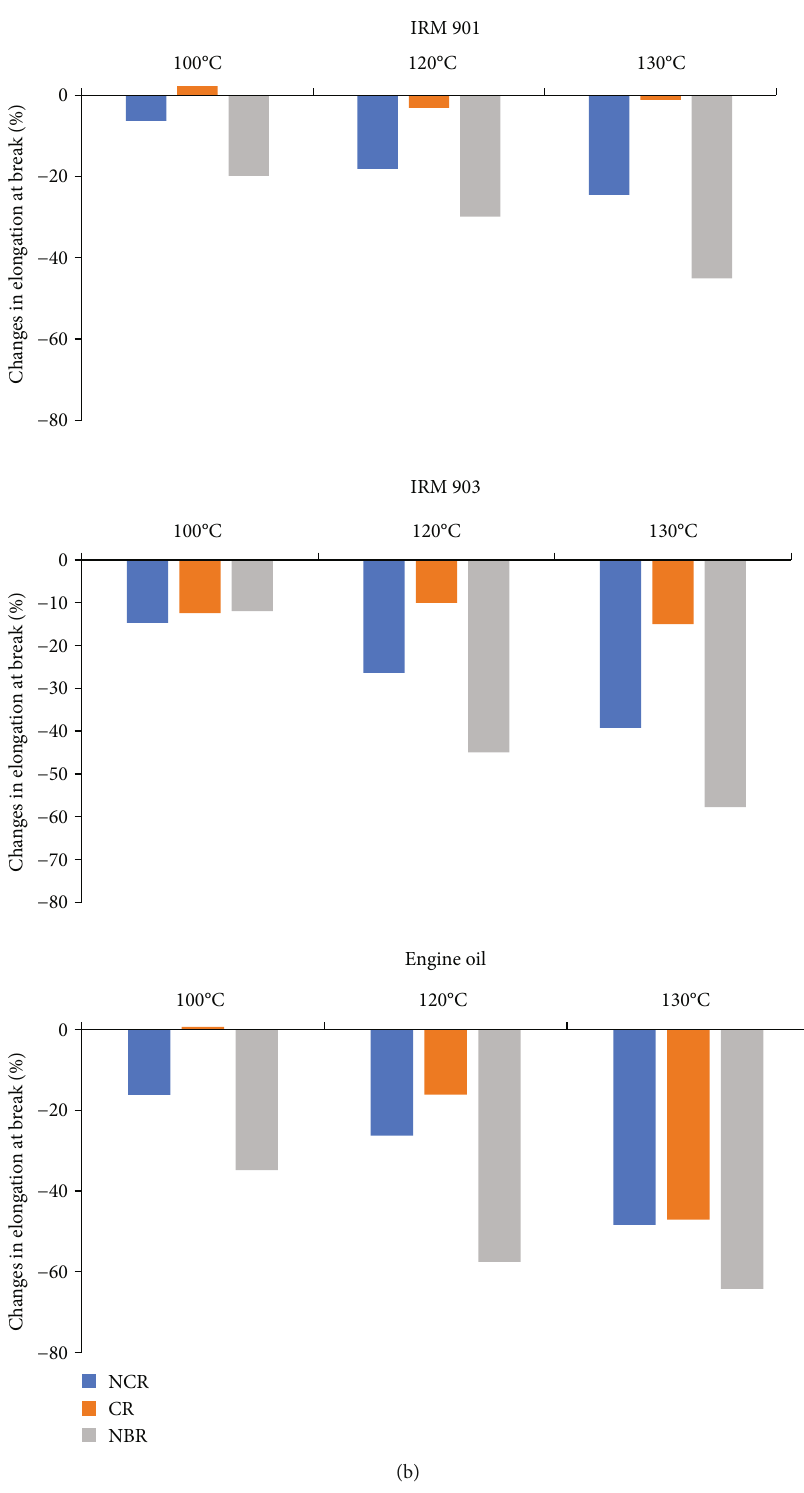
Figure 7: Changes in (a) tensile strength and (b) elongation at break of vulcanizates of acrylonitrile-chloroprene rubber (NCR), chloroprene rubber (CR), and nitrile rubber (NBR) as a function of temperature after 72hrs in di ff erent test